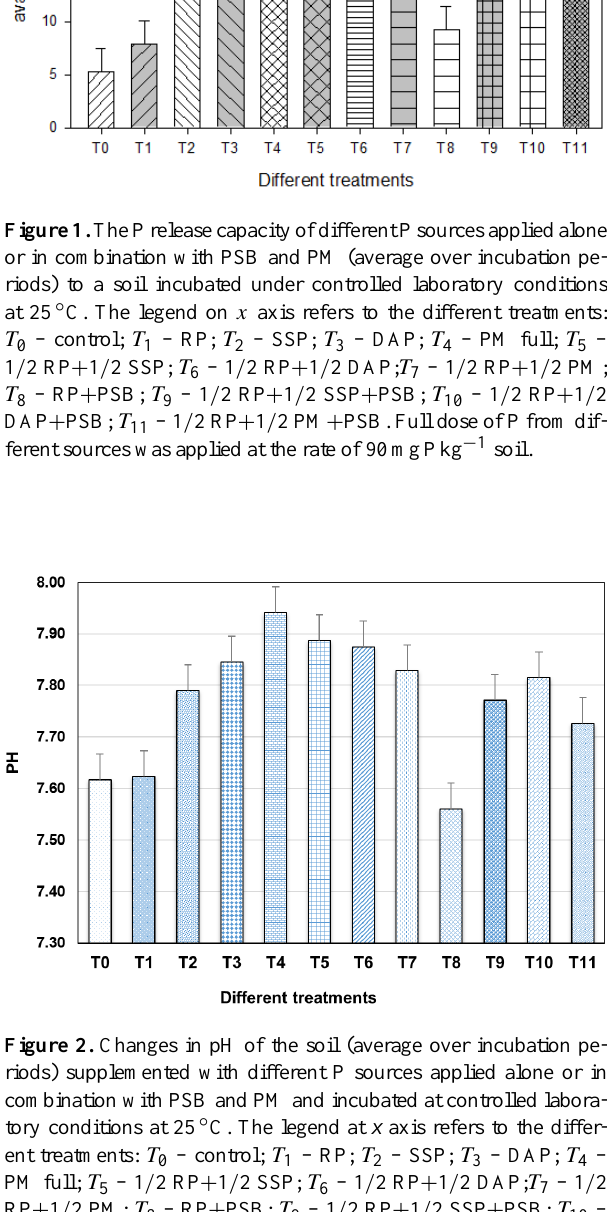
of P from different sources was applied at the rate of 90mgPkg − 1